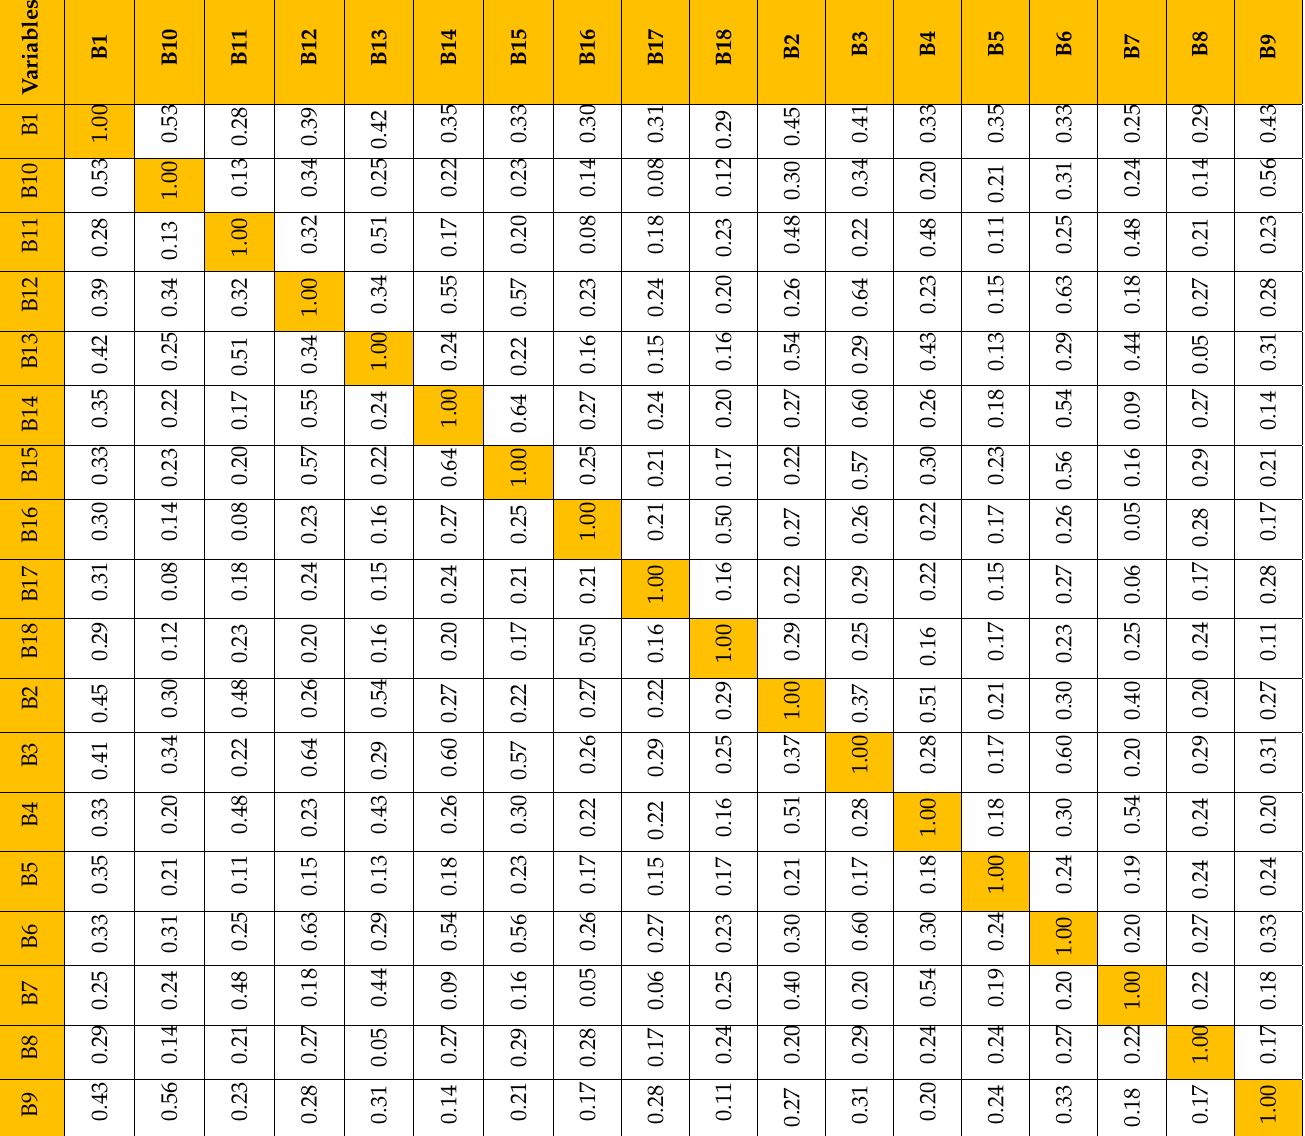
Table 7. Empirical correlation